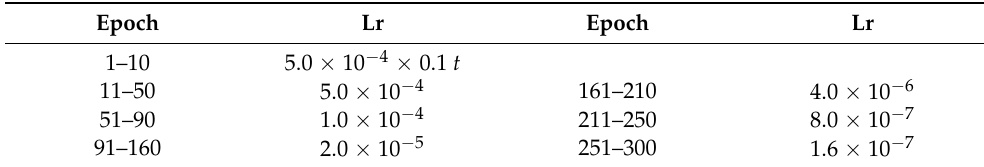
Table 2. The setting of the learning